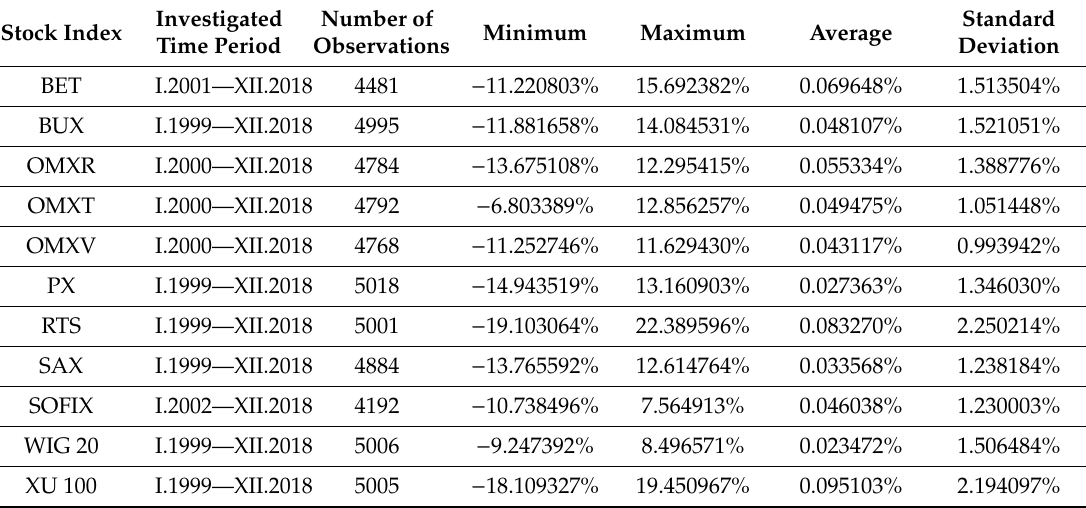
Table 1. Daily returns of analyzed stock indices—descriptive